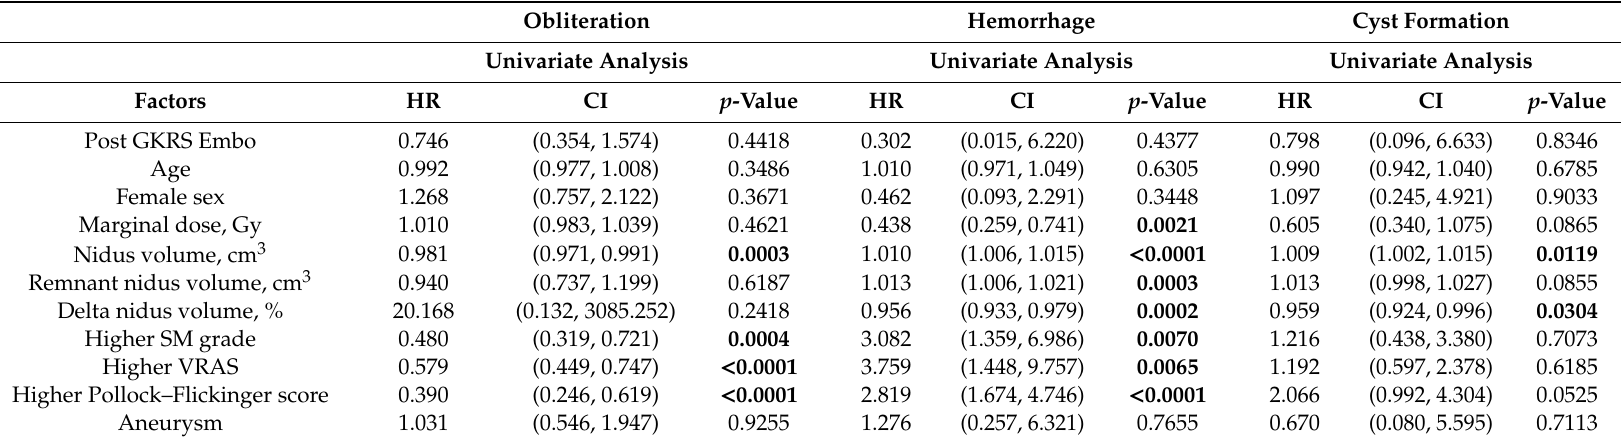
Boldface type indicates statistical significance ( p <